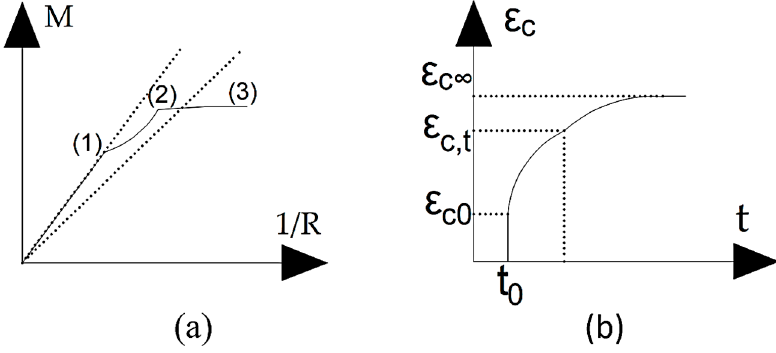
graphic of creep, adapted from [22]. (1) non-crack mode, (2) transition mode, (3) crack mode